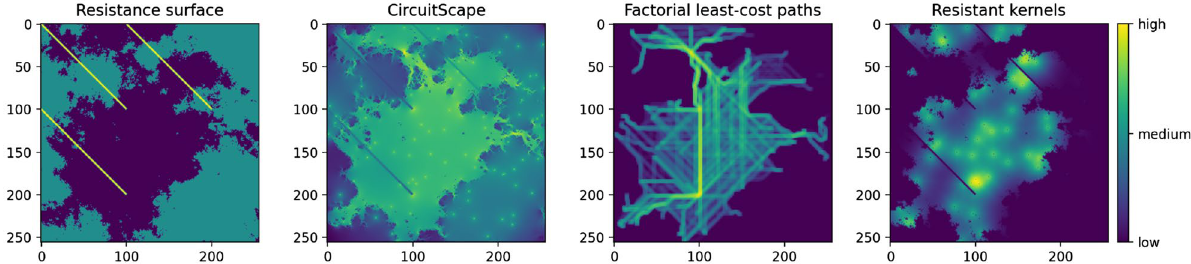
Figure 1. An example of a resistance surface (left), and the resulting connectivity predictions of Circuitscape, factorial least-cost paths and resistant kernels applied to this resistance surface. The input data for these models are the resistance surface, together with 100 uniformly randomly selected source points on the resistance